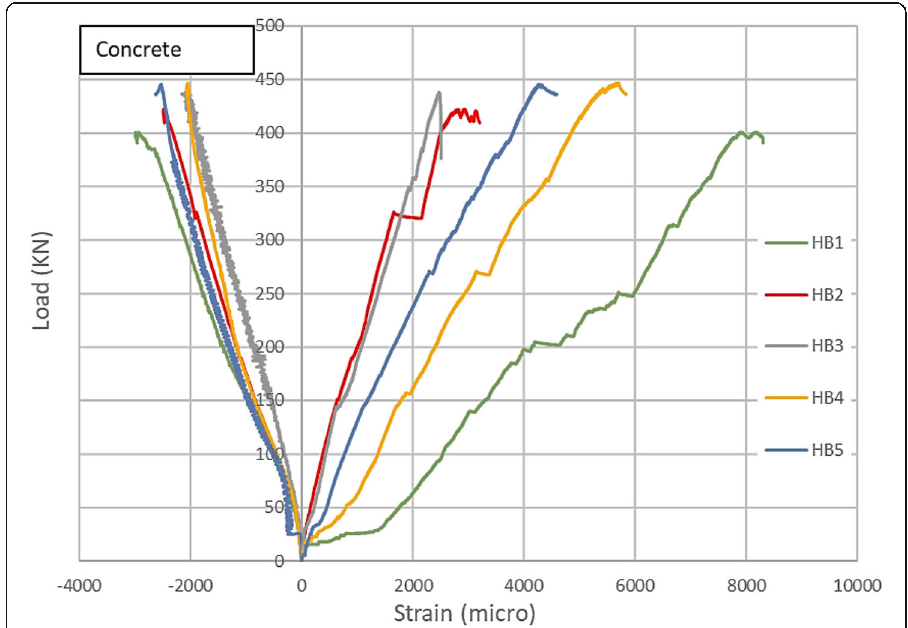
Fig. 12 Mid-span longitudinal and top surface concrete strain of tested beam